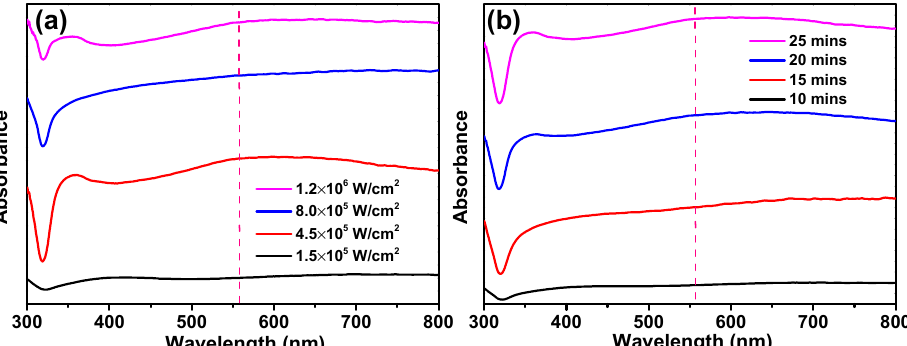
Figure 4. Absorbance spectra of the silver nanoaggregates-based SERS substrates prepared ( a ) at irradiation intensities of 1.5 × 10 5 , 4.5 × 10 5 , 8.0 × 10 5 , and 1.2 × 10 6 W / cm 2 , respectively, with a fixed irradiation time of 25 min; ( b ) at irradiation times of 10, 15, 20, and 25 min, respectively, with a fixed irradiation intensity of 4.5 × 10 5 W / cm 2 .